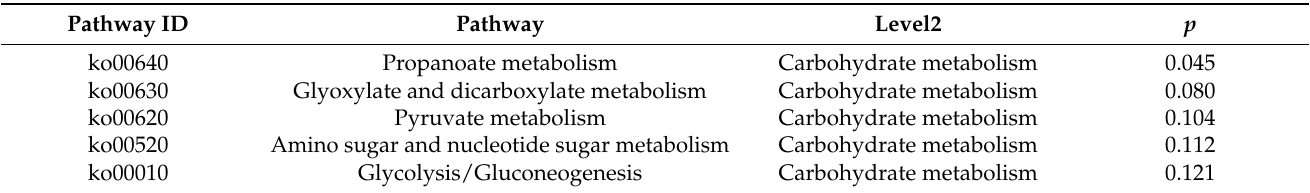
Table 8. KEGG enrichment analysis of predicted DEM target genes in the comparison of RACK vs. RACT.